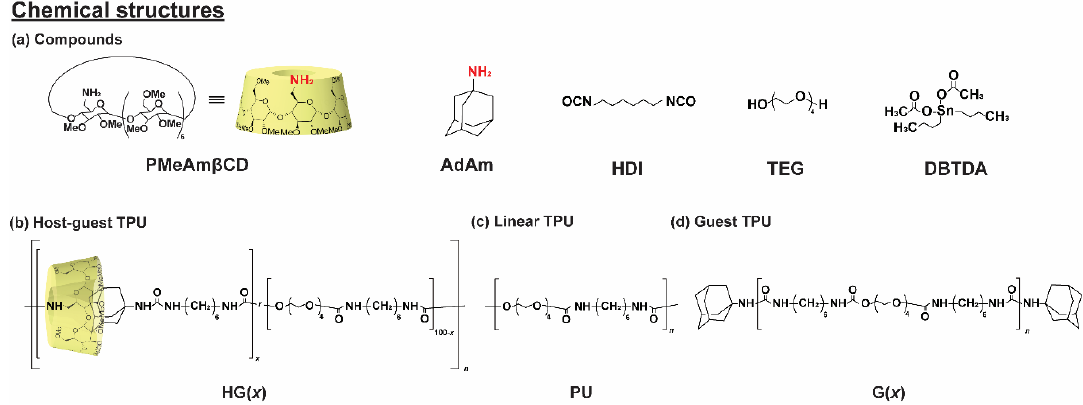
Figure 1. ( a ) Chemical structures of the compounds: permethylated amino β CD (PMeAm β CD), adamantane amine (AdAm), hexamethylene diisocyanate (HDI), tetraethylene glycol (TEG), and dibutyltin diacetate (DBTBA). Chemical structures of thermoplastic polyurethane (TPU) derivatives: ( b ) host-guest (HG) TPU (HG( x )), ( c ) linear TPU (PU), and ( d ) guest TPU (G( x )). The proportions of the host and guest units in TPU are indicated by “ x ” (HG( x ) and G( x )), which represent the mol% of the PMeAm β CD and AdAm units.